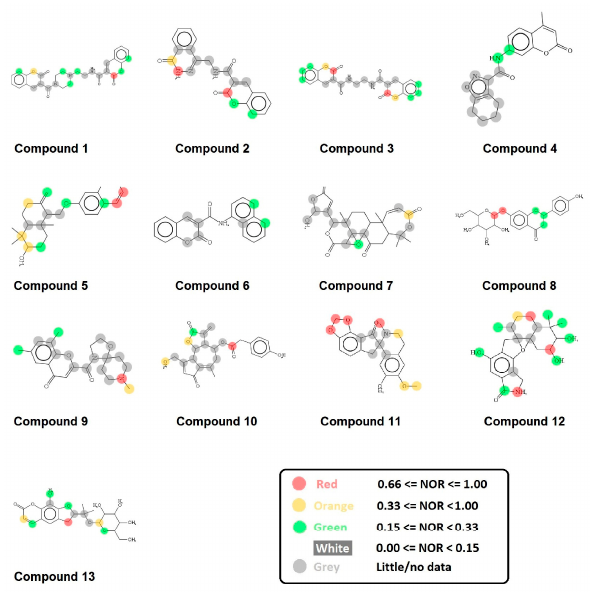
Figure 9. Metabolic sites prediction by MetaPrint2D. Diagrammatical representation of MetaPrint2D plots of common compounds (2-D format) for Ebola viral proteins, VP35 and VP40. Sites of metabolism are representing by colours as Red: most favourable site, Orange: medium/moderate, Green: Low, very low is uncoloured; and grey: no data available. NOR represents Normalized Occurrence Ratio; high NOR showed the more frequently reported metabolic sites in the metabolite database.